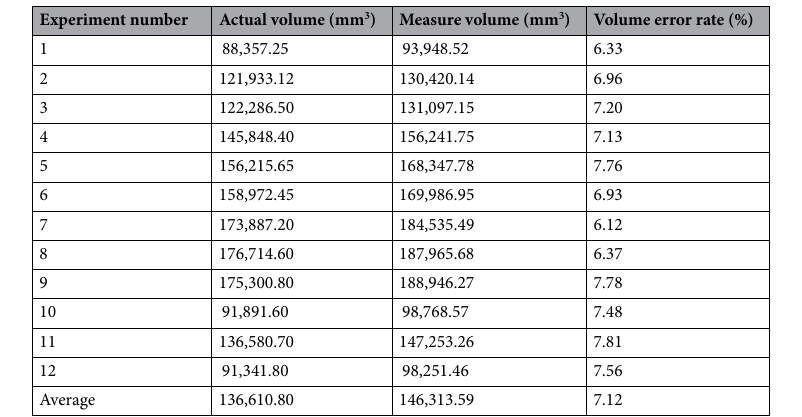
Table 5. Data analysis of experimental